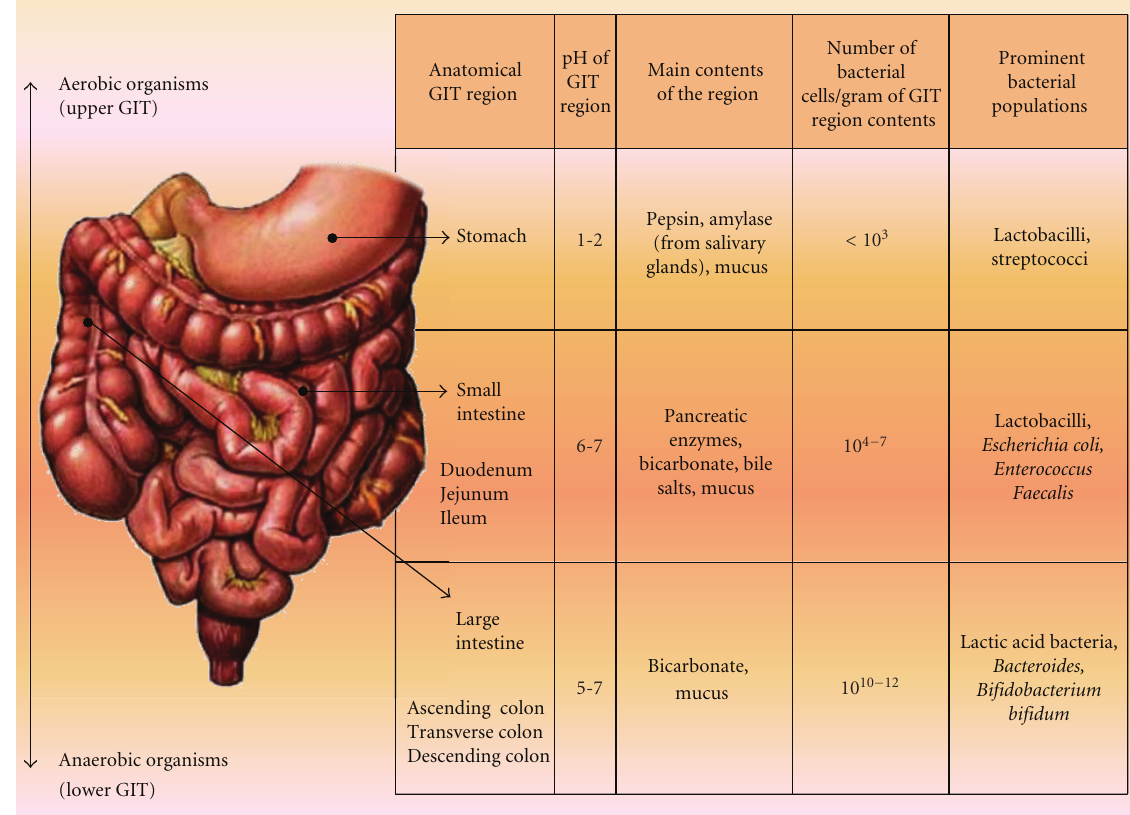
Figure 1: The GIT characteristics (oxygen distribution, pH, bacterial populations, and bacterial cell counts) and the localization of the various gut bacterial populations, termed